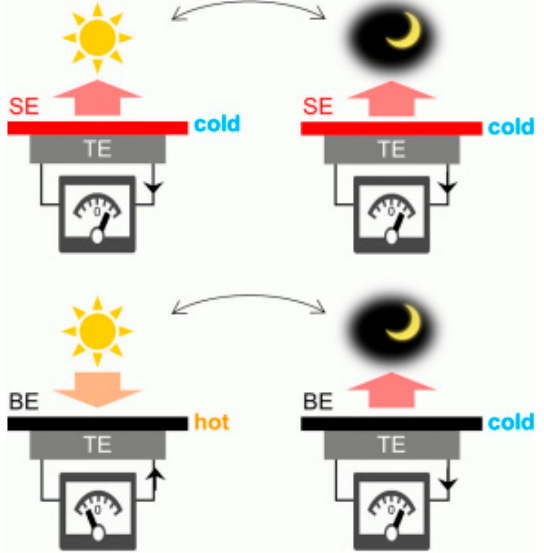
Figure 42. Theoretical illustration of TE devices with a broadband emitter (BE) and a wavelength selective emitter (SE) on top [189].